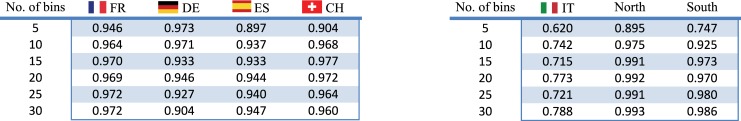
These two tables show values of R
2 coupled to the best fits of data sets LMi,y versus Γi,y for all the countries considered and for several choices of binning; the case with 30 bins is the one shown in Fig 1.As for Italy, whatever the level of resolution we fix (i.e., whatever the amount of bins we use), the best fit considering the country as a whole is always significantly worst than the one obtained considering Northern and Southern regions separately.